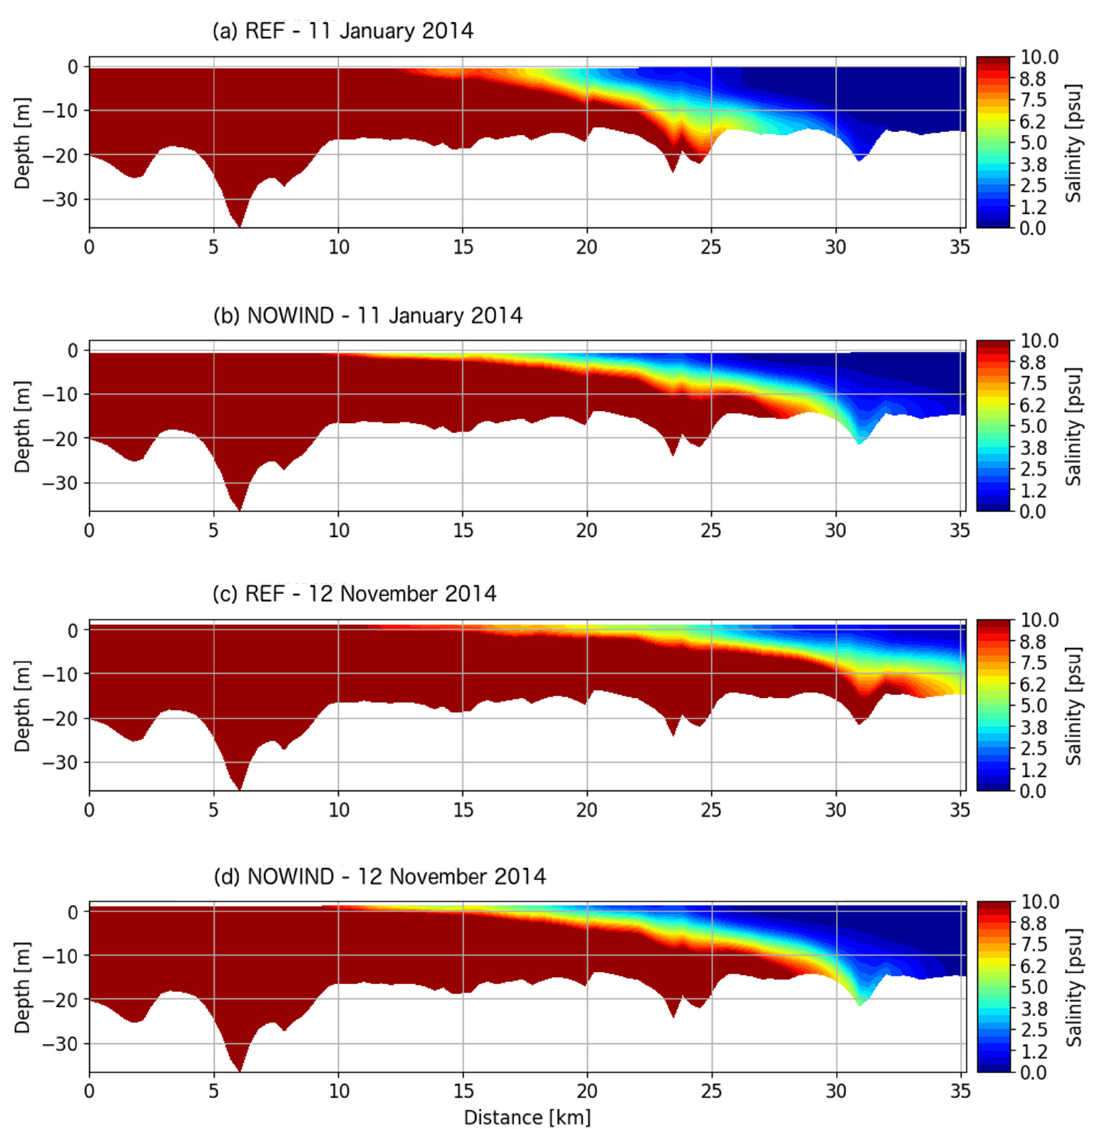
Figure 6. Tidally averaged salinity structure in the along-channel transect of the south channel. ( a , b ) event of January and ( c , d ) event of November 2014. Results from the reference simulation ( a , c ) are compared with results from the NOWIND run ( b , d ). In order to better visualize the difference in salinity intrusion, the range for salinity was intentionally set to 0–10 psu.